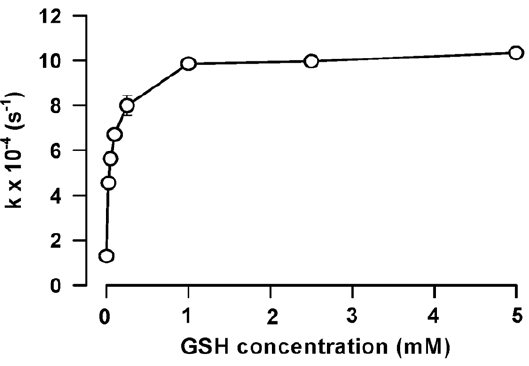
Figure 1. Denitrosation of N-acetyl-nitroso-Trp (NANT) by glutathione (GSH). The decomposition of NANT (100 m M)